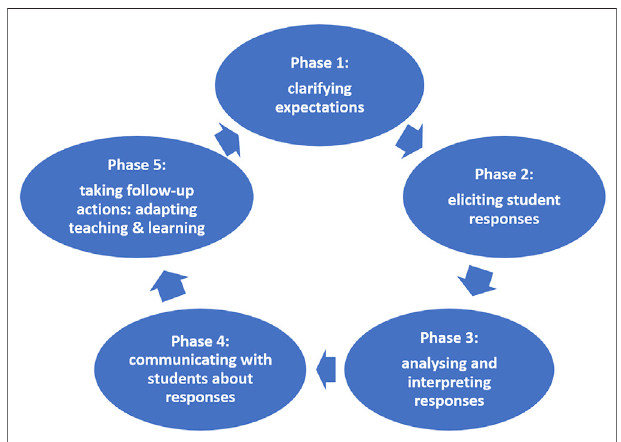
FIGURE 1 | The formative assessment cycle (Gulikers and Baartman, 2017; Veugen et al., 2021).